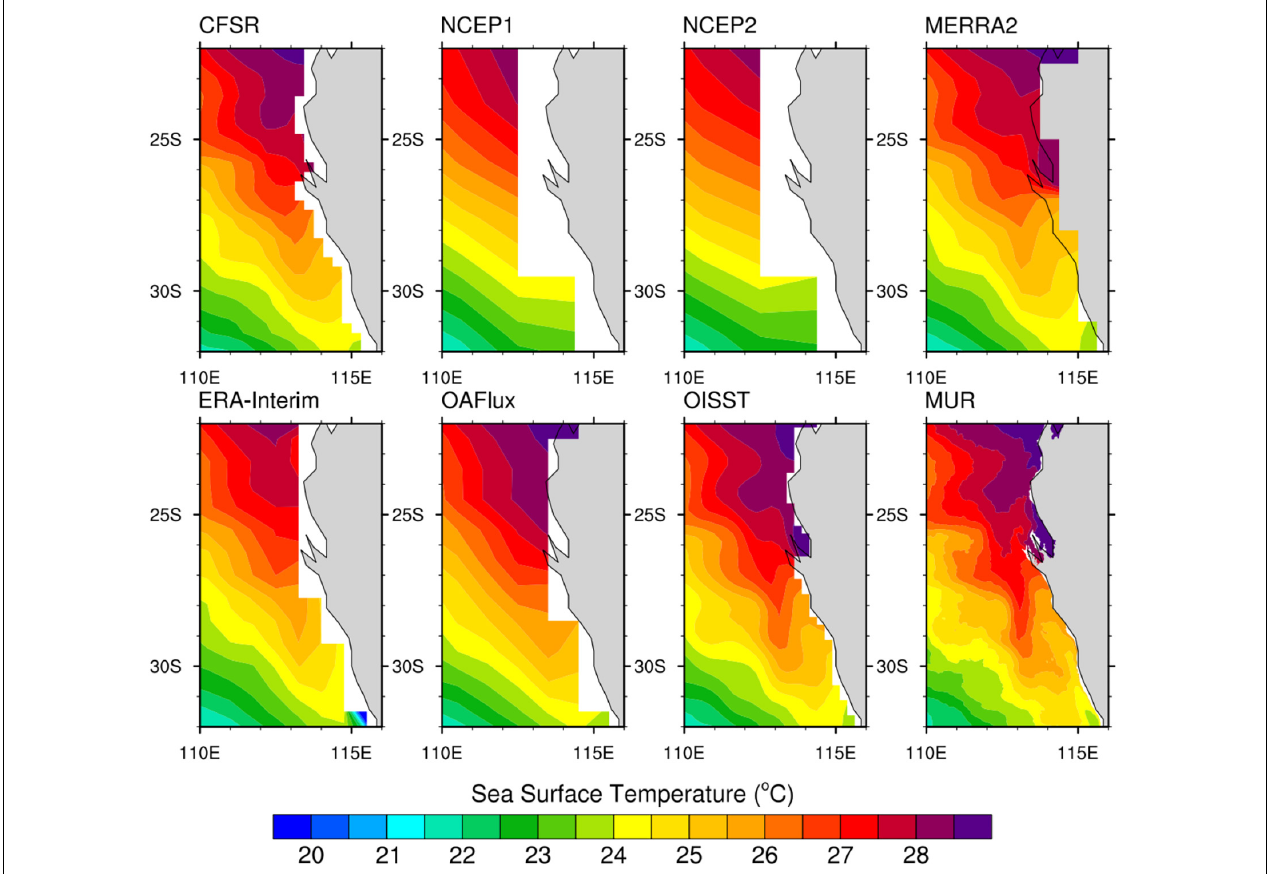
FIGURE 11 | Mean SST of January and February 2011 over the west coast of Australia from different SST